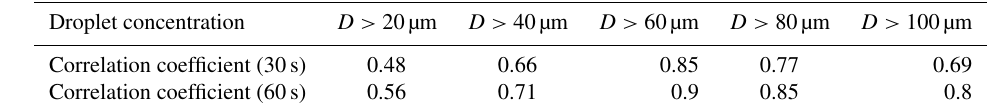
Table 1. Correlation coefficient between droplet concentration in different size ranges and concentration of small faceted ice crystals with L max < 100µm for the cloud segment in Fig. 5 for 30 and 60s averaging.